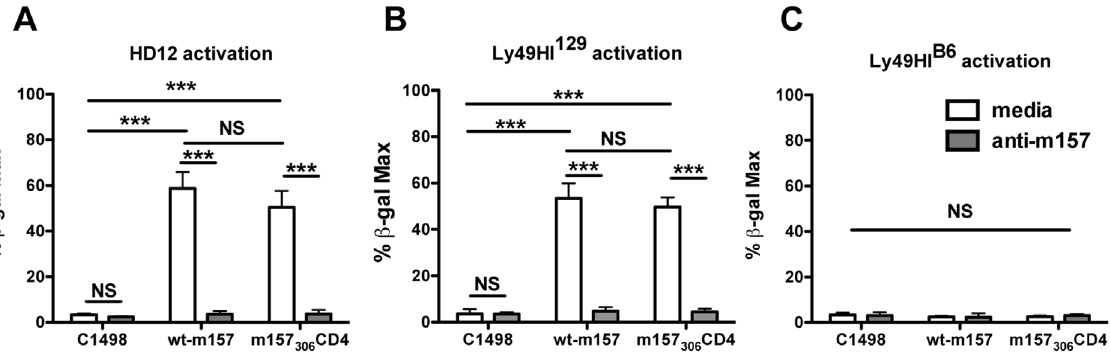
Figure 2. Transmembrane m157 stimulates both activating and inhibitory Ly49 reporter cells. C1498 cells transfected with wt-m157 or m157 306 CD4 were incubated with ( A ) Ly49H B6 -expressing HD12 cells, ( B ) Ly49HI 129 -expressing cells, or ( C ) Ly49HI B6 -expressing cells overnight in the presence or absence of anti-m157 mAb (6D5). Results are expressed as the frequency of maximum b -gal production (determined by stimulating cells with PMA and ionomycin). NS, not significant ( P . 0.05); *** P , 0.001 (two-tailed unpaired Student’s t-test). Results are representative of 3 experiments (error bars depict SEM).